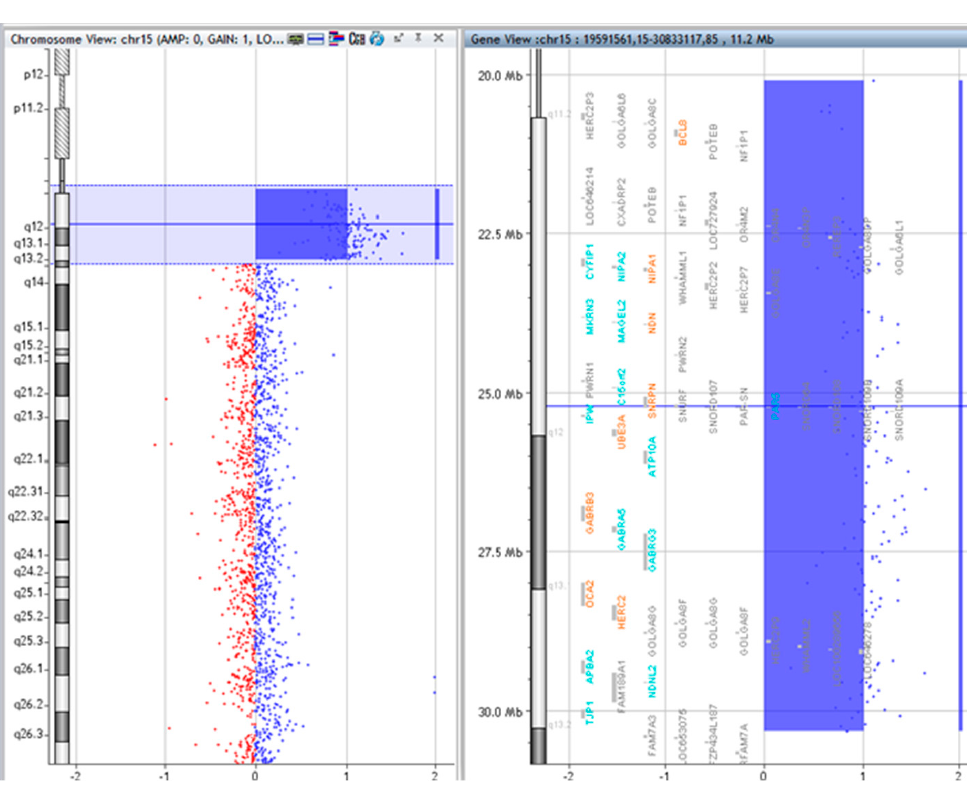
Table 1. Molecular subtype and array CGH results of the idic(15) chromosomes.